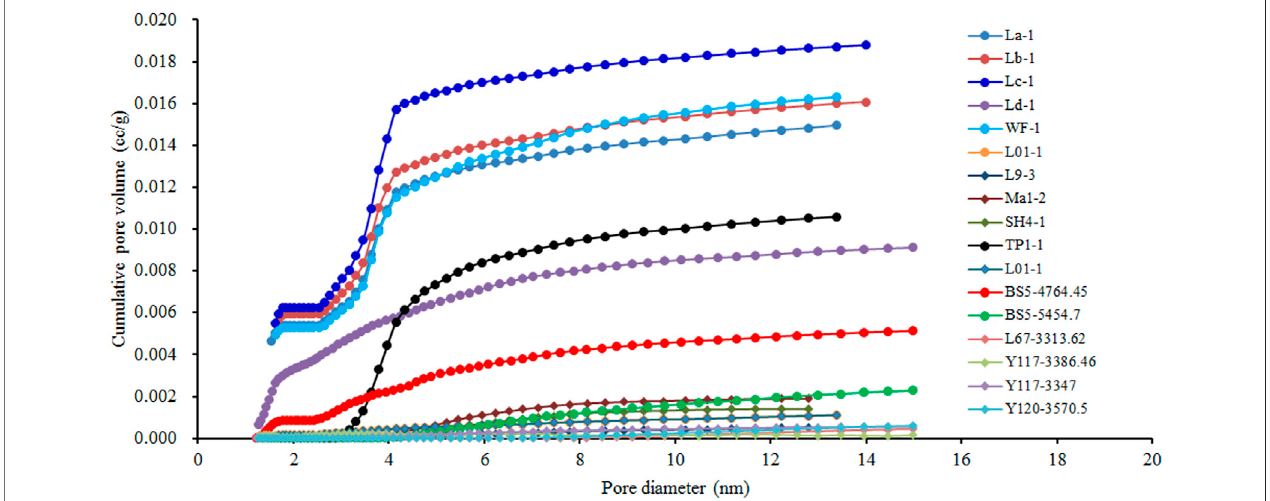
FIGURE 9 | Relationship between pore diameter and cumulative pore volume of shale samples in the study area.